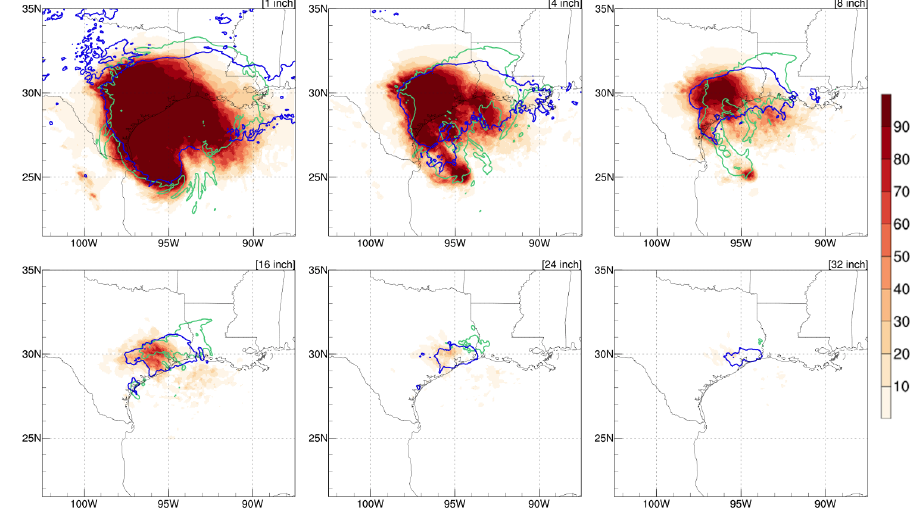
Figure 12. 126-h probabilistic rainfall for Harvey cycle 0000 UTC 25 August. Thresholds are 1, 4, 8, 16, 24, and 32 inches for panels from left to right and top to bottom. The blue lines are contours of thresholds from Stage IV, and the green lines are from HB17. The shaded contours are from H17E. The corresponding H17E, HB17, and Best Track positions are shown in Figure